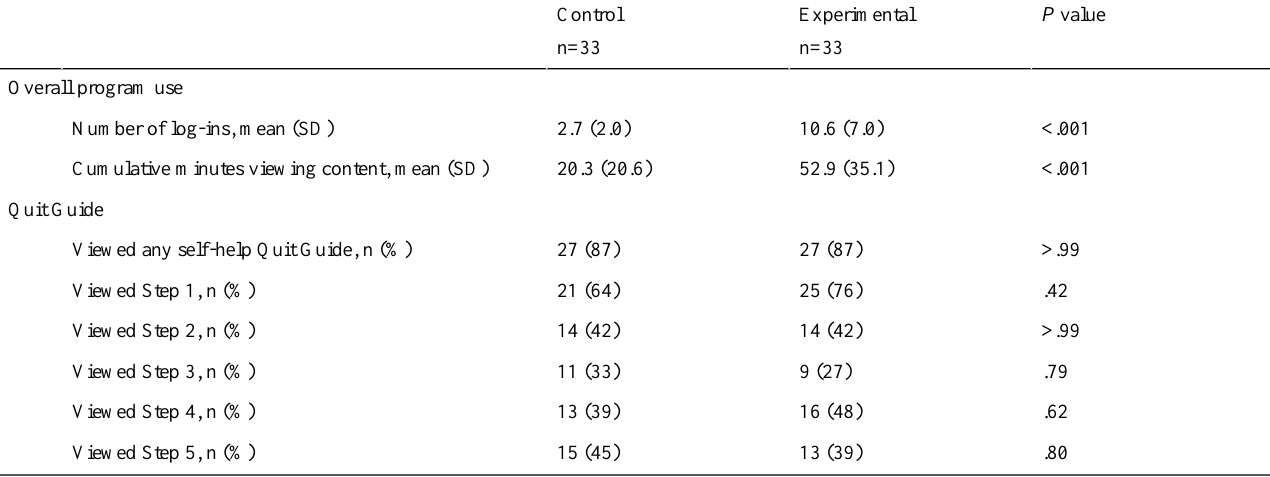
Table 2. Program utilization by randomization